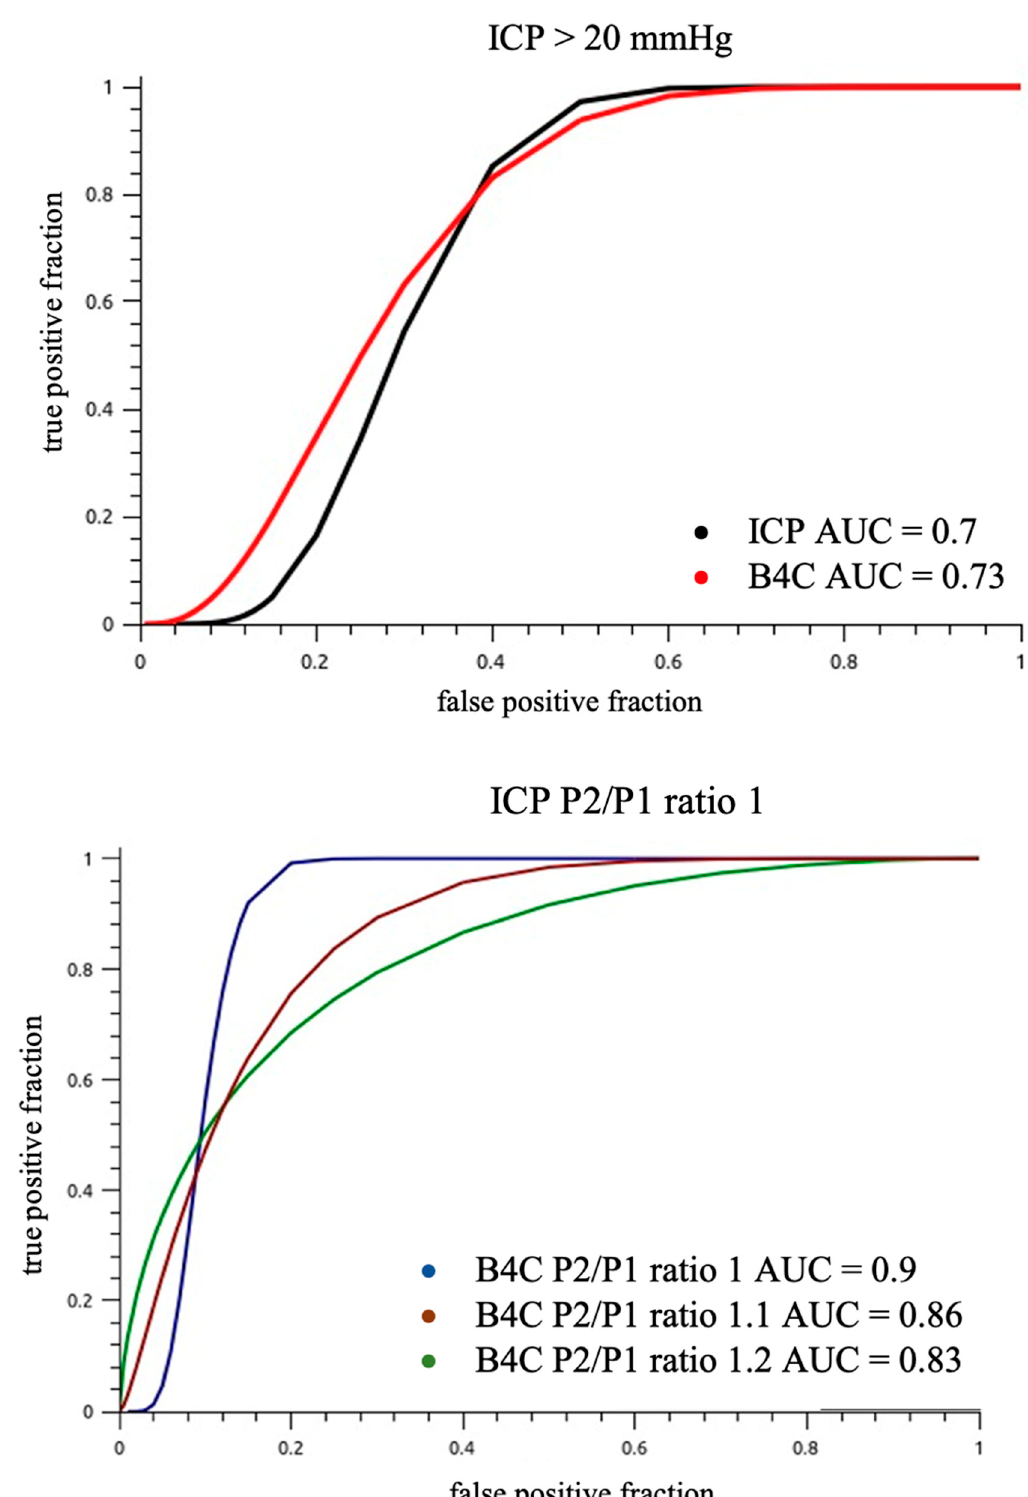
Figure 7. Entire sample ROC analysis of ICP and B4C P2/P1 ratios for an ICP value cut-off >20 mmHg ( up ). The power of predicting intracranial hypertension was reduced because of sample heterogeneity. The B4C P2/P1 ratio cut-off 1 ( down ) was equivalent to ICP P2/P1 ratio cut-off 1 (AUC 0.9). For our full sample, power to discriminate ICH (ICP > 20 mmHg) with B4C P2/P1